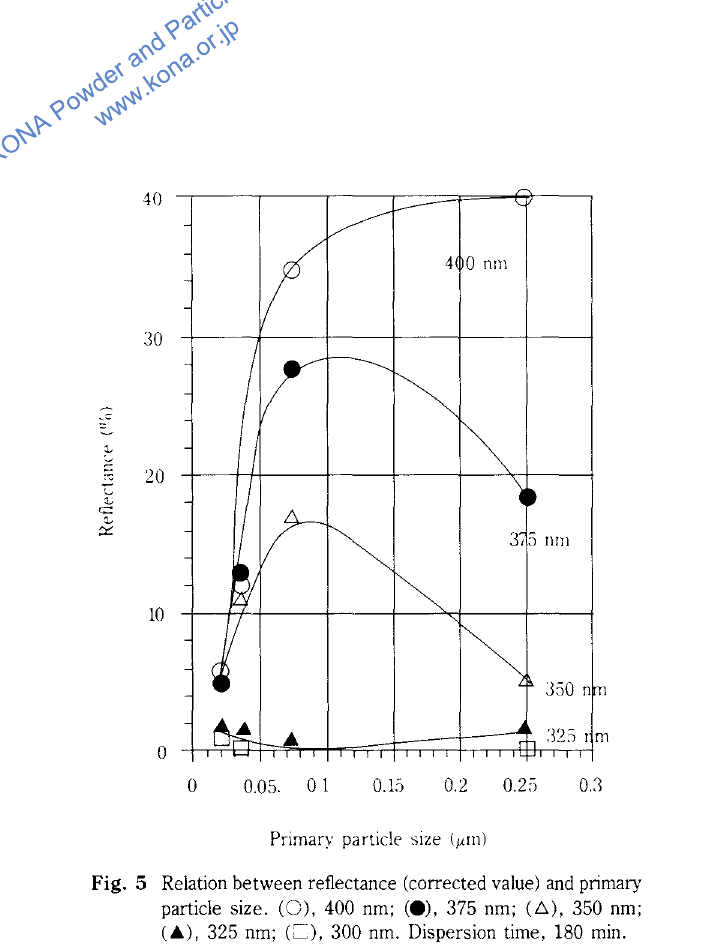
Fig. 5 Relation between reflectance (corrected value) and primary particle size. (0). 400 nm; (e), 375 nm; (£-.), 350 nm; c•l. 325 nm; (:::::), 300 nm. Dispersion time, 180 min.